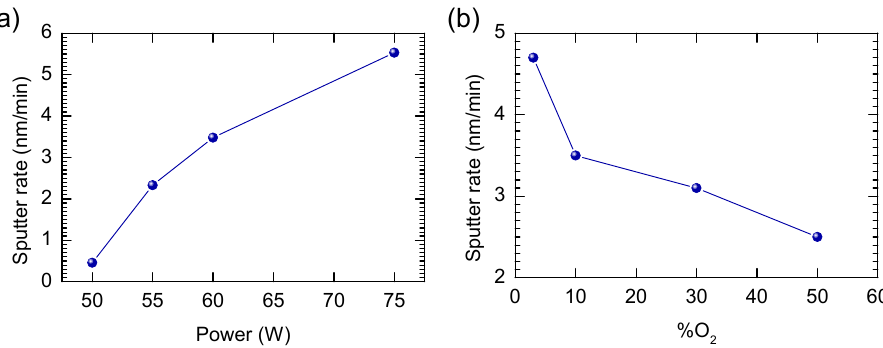
Figure 1. Sputter rate in dependence of ( a ) power change keeping other parameters fixed (50%/50% O 2 /Ar) and ( b ) oxygen content change (rest Ar) keeping other parameters fixed ( p = 60 W).